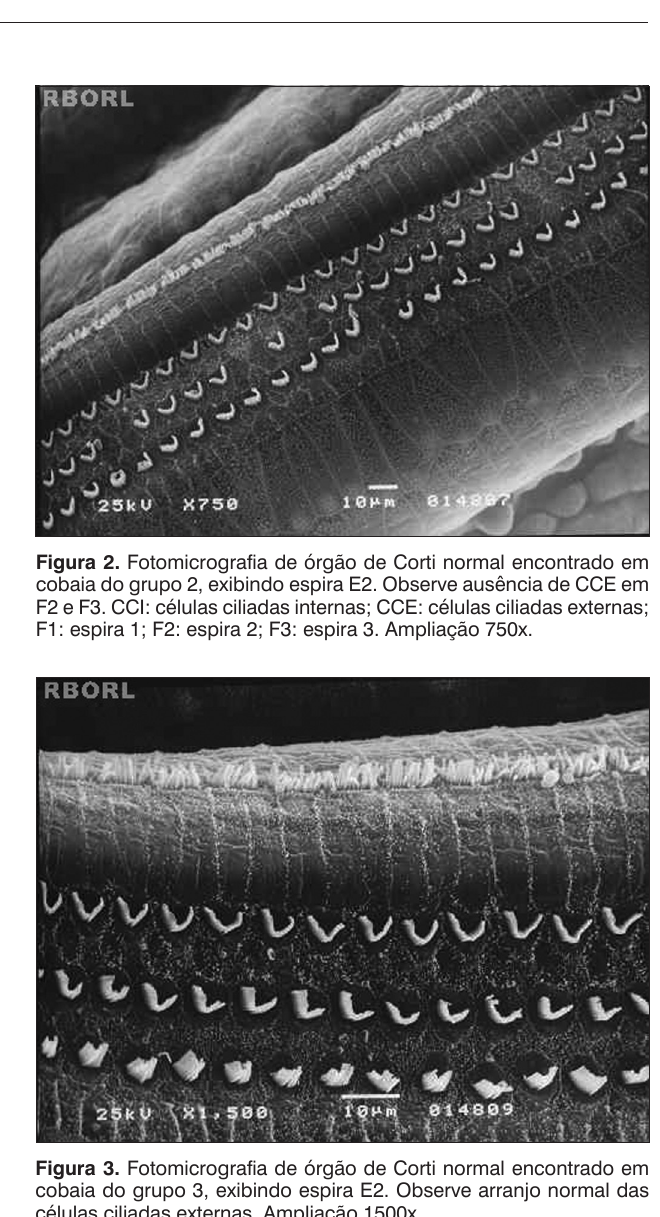
Figura 5. O giro apical não foi analisado neste estudo por ser responsável pela detecção de tons graves e pelo dano ototóxico ser observado principalmente em tons agudos. Além disso, esse giro exibe um desarranjo natural em suas células, o que dificultaria a análise anatômica. As células ciliadas internas (CCI) não